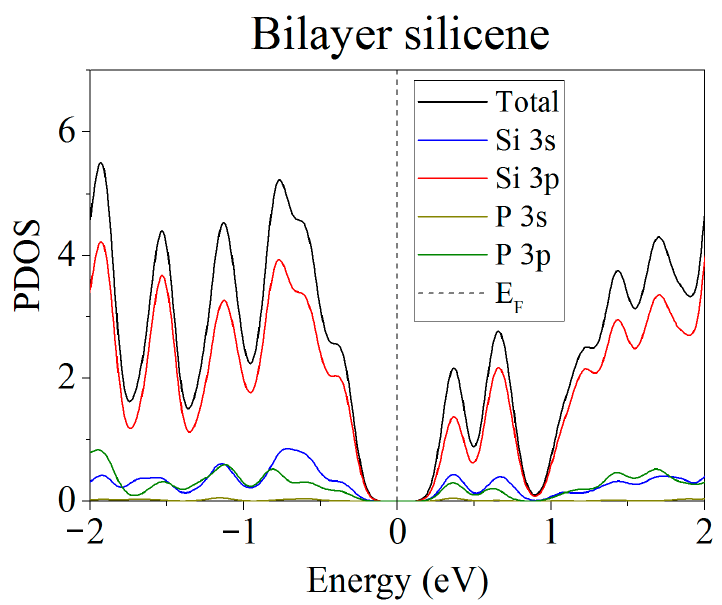
Figure 4. Partial spectrum of electronic states of two-layer silicene obtained after the replacement of 2 Si atoms belonging to each of the lower sublattices by phosphorus.